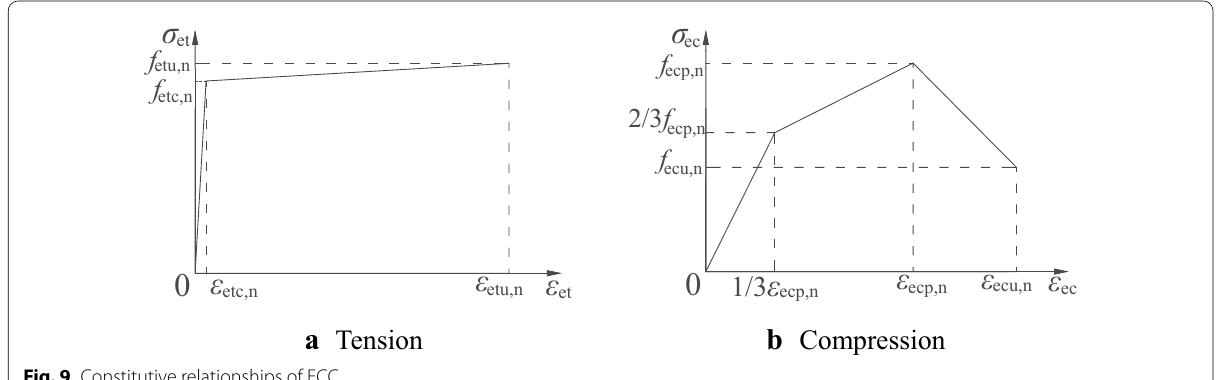
Fig. 9 Constitutive relationships of